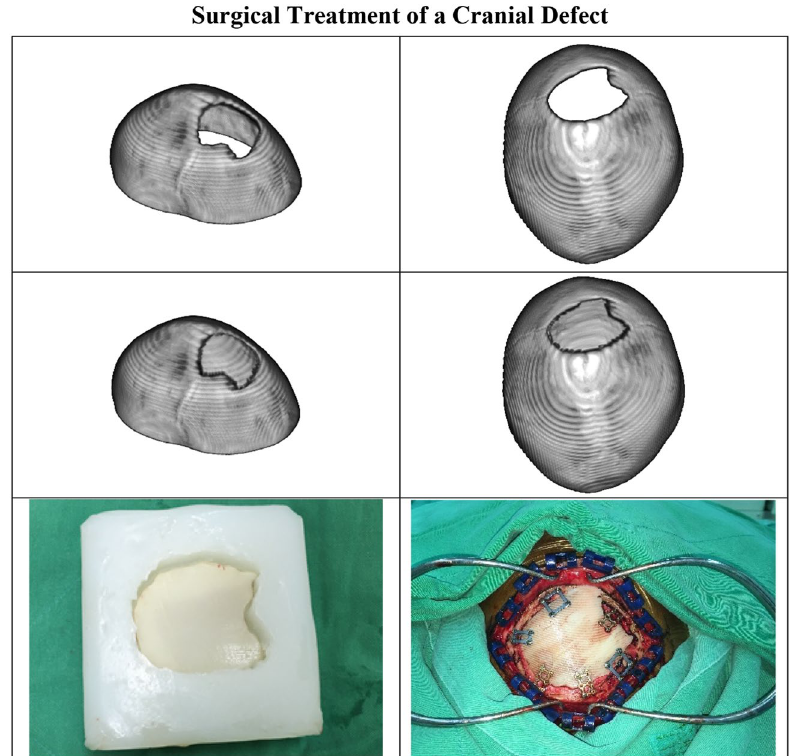
Figure 3. Clinical cranial reconstruction. The first row shows the isometric and top views of the original cranial model. The second row shows the isometric and top views of the repaired cranial model using the implant created by the proposed deep learning system. The last row shows the bone-cement implant molded with silicone rubber (left photo), and a scene of the surgery when the implant was fixed to the skull (right